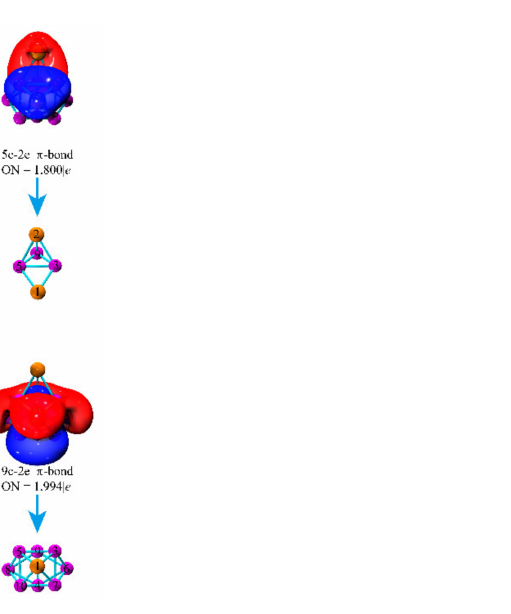
Figure 6. AdNDP chemical bonds and the corresponding structural units for the Ca 2 Mg 8 cluster. (ON denotes the occupation number). Three 3c-2e σ -bonds with an ON of 1.745–1.766 |e| are formed by two opposite